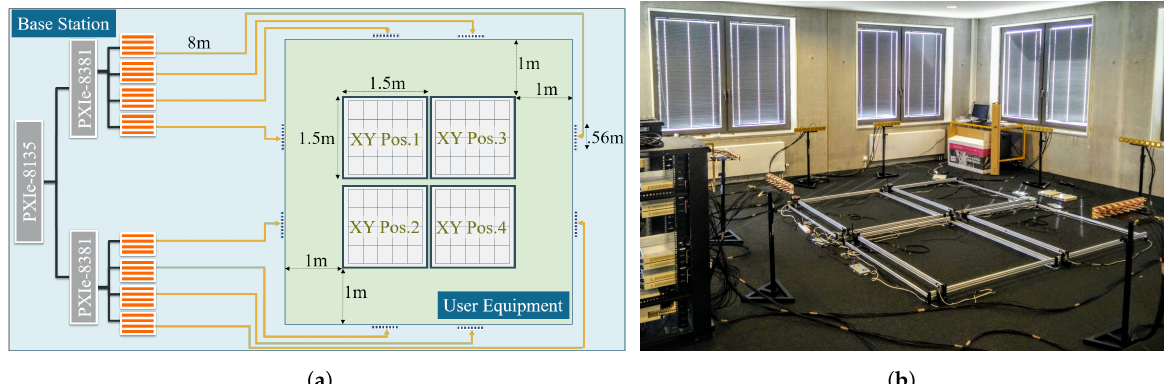
Figure 3. Massive MIMO LoS experimental scenario deployment for eight distributed ULA antenna array. ( a ) Experimental schema. ( b ) Real